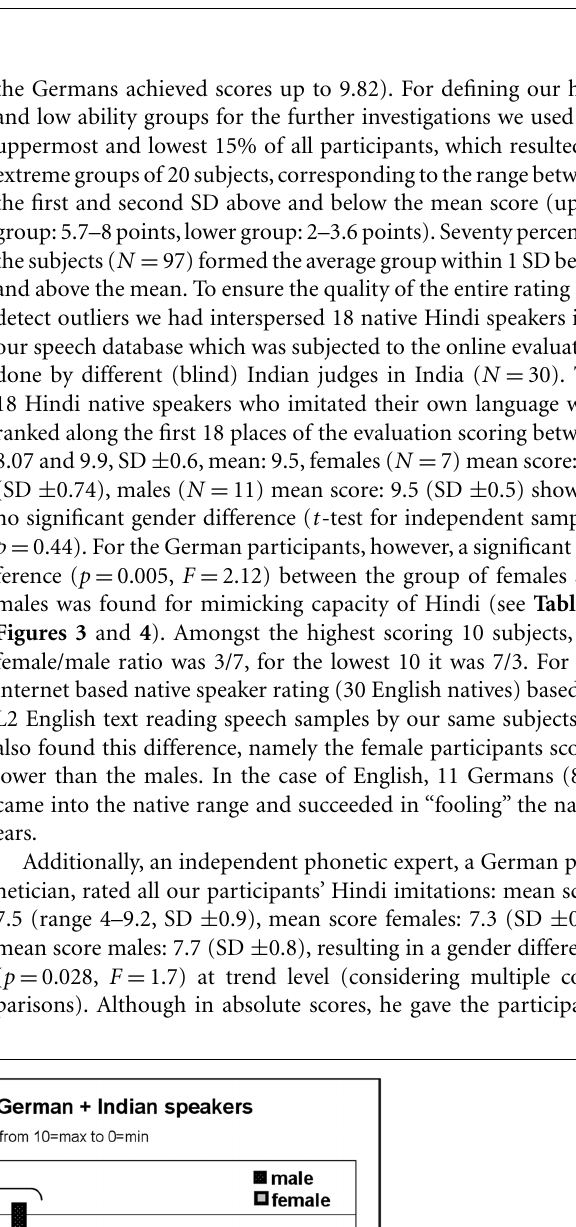
FIGURE 2 | Hindi score distribution: Hindi speech imitation score (reflecting degree of “native-speaker-likeness”) distribution (as rated by 30 Indian native judges, 15 females) including the scores for the native Hindi speakers immersed into the German subject pool. German subjects, N = 138; immersed Indian natives N = 18; overall N = 156. Maximum score for sounding “native-like” Indian = 10; minimum vote = 0. 30 Indian (online) judges had to click an intuitive rating bar